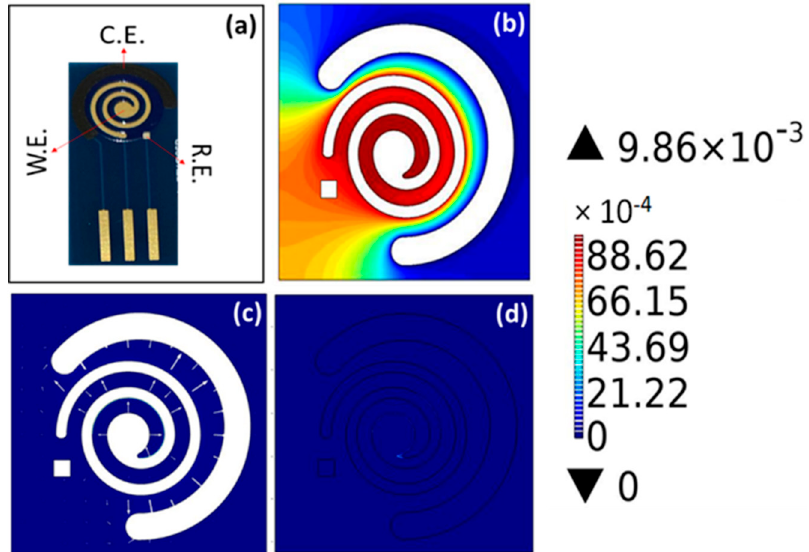
Figure 1. ( a ) Actual image of the spiral electrochemical notification coupled electrode (SENCE) platform. ( b ) Potential contour describing the field distribution. ( c ) Current distribution of the sensor from the working electrode (WE) to the counter electrode (CE) and from the WE to the reference electrode (RE). ( d ) Total power dissipation of the SENCE.